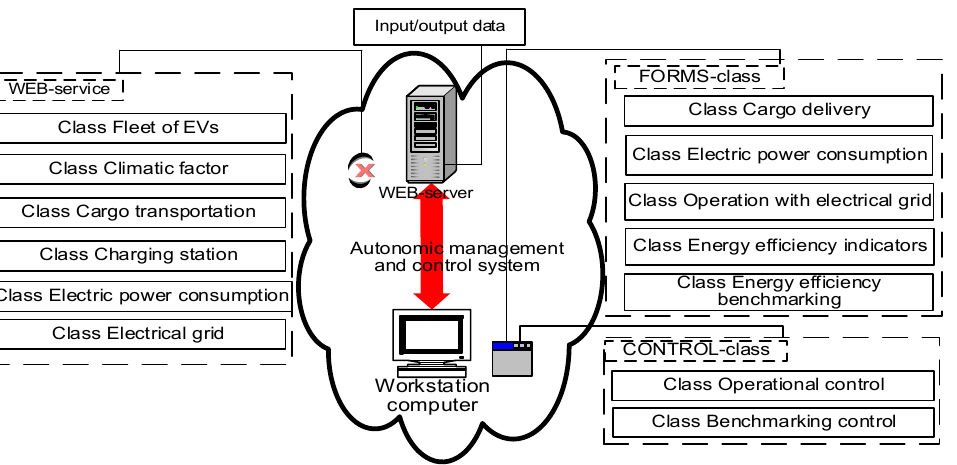
Figure 2. The architecture of information technology for the integrated energy-efficient monitoring of an independent fleet of freight EVs within the